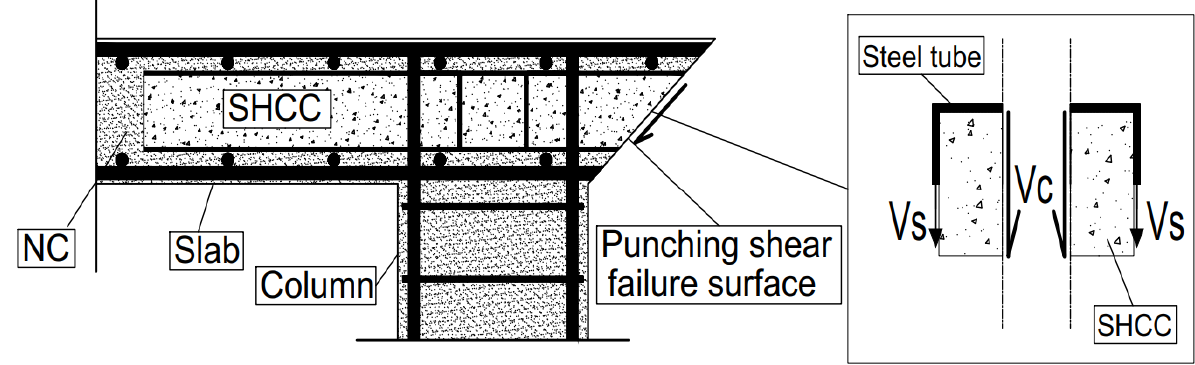
Figure 3. Distribution of shear forces in slabs reinforced with SHCC-filled steel tubes.